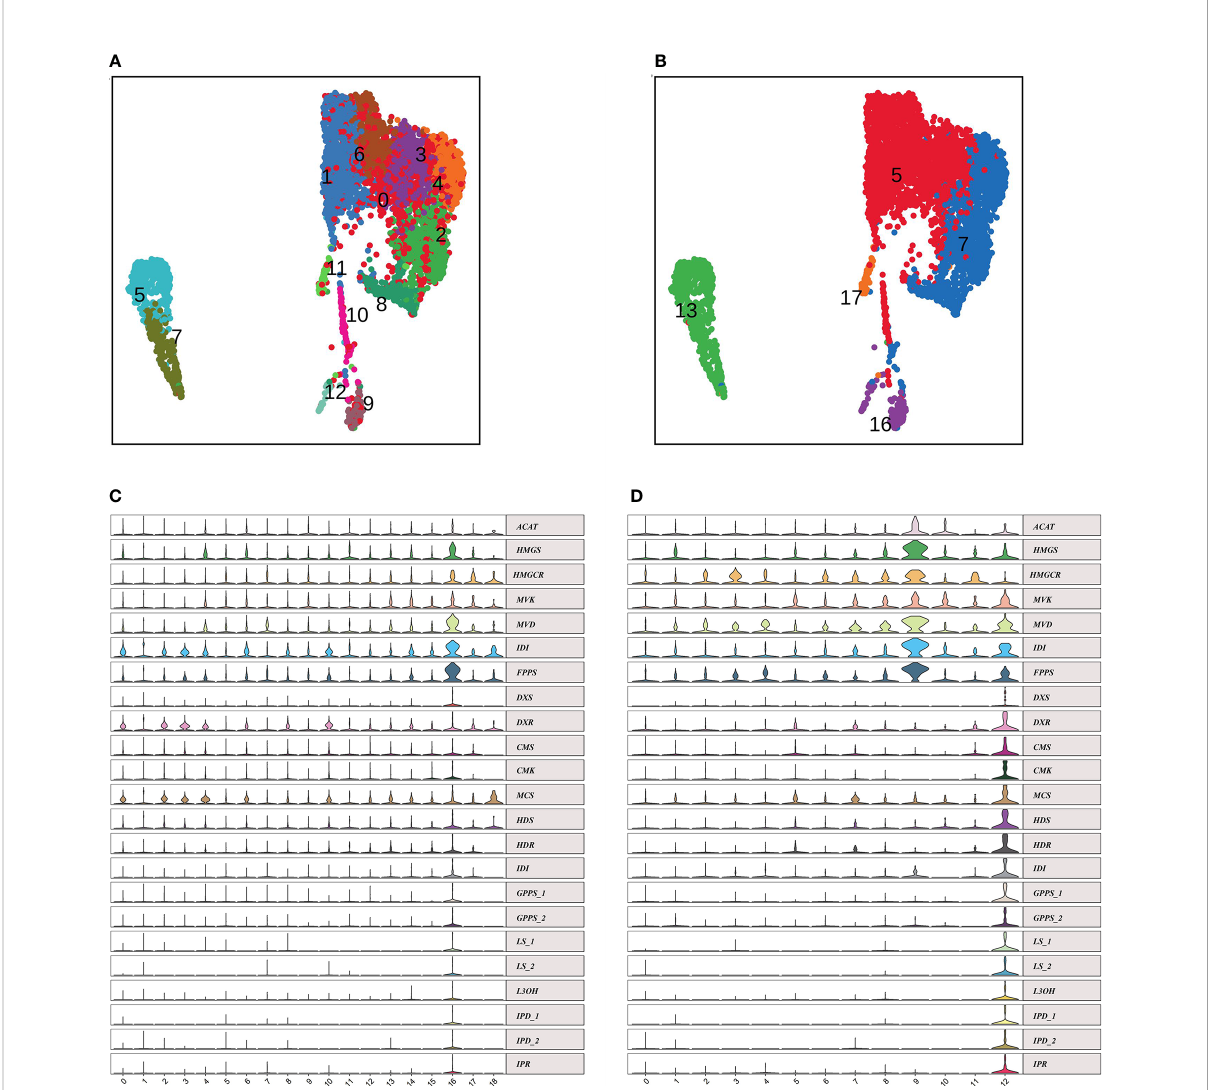
FIGURE 3 Epidermal cells differentiating toward glandular trichomes. (A, B) UMAP projections showing epidermal cell populations ( A named by E0 to E12, sub-cell clusters; B named by clusters 5, 7, 13, 16 and 17 ). (C, D) Violin plots of monoterpene biosynthesis genes in clusters (C) and reEC (D) . EC, epidermal cell; UMAP, uniform manifold approximation and